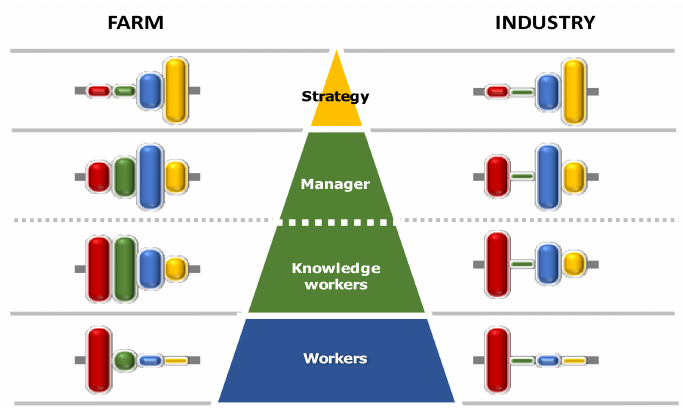
Figure 5. Probable combination of MPIs in the di ff erent hierarchic levels for agricultural and industrial enterprises.